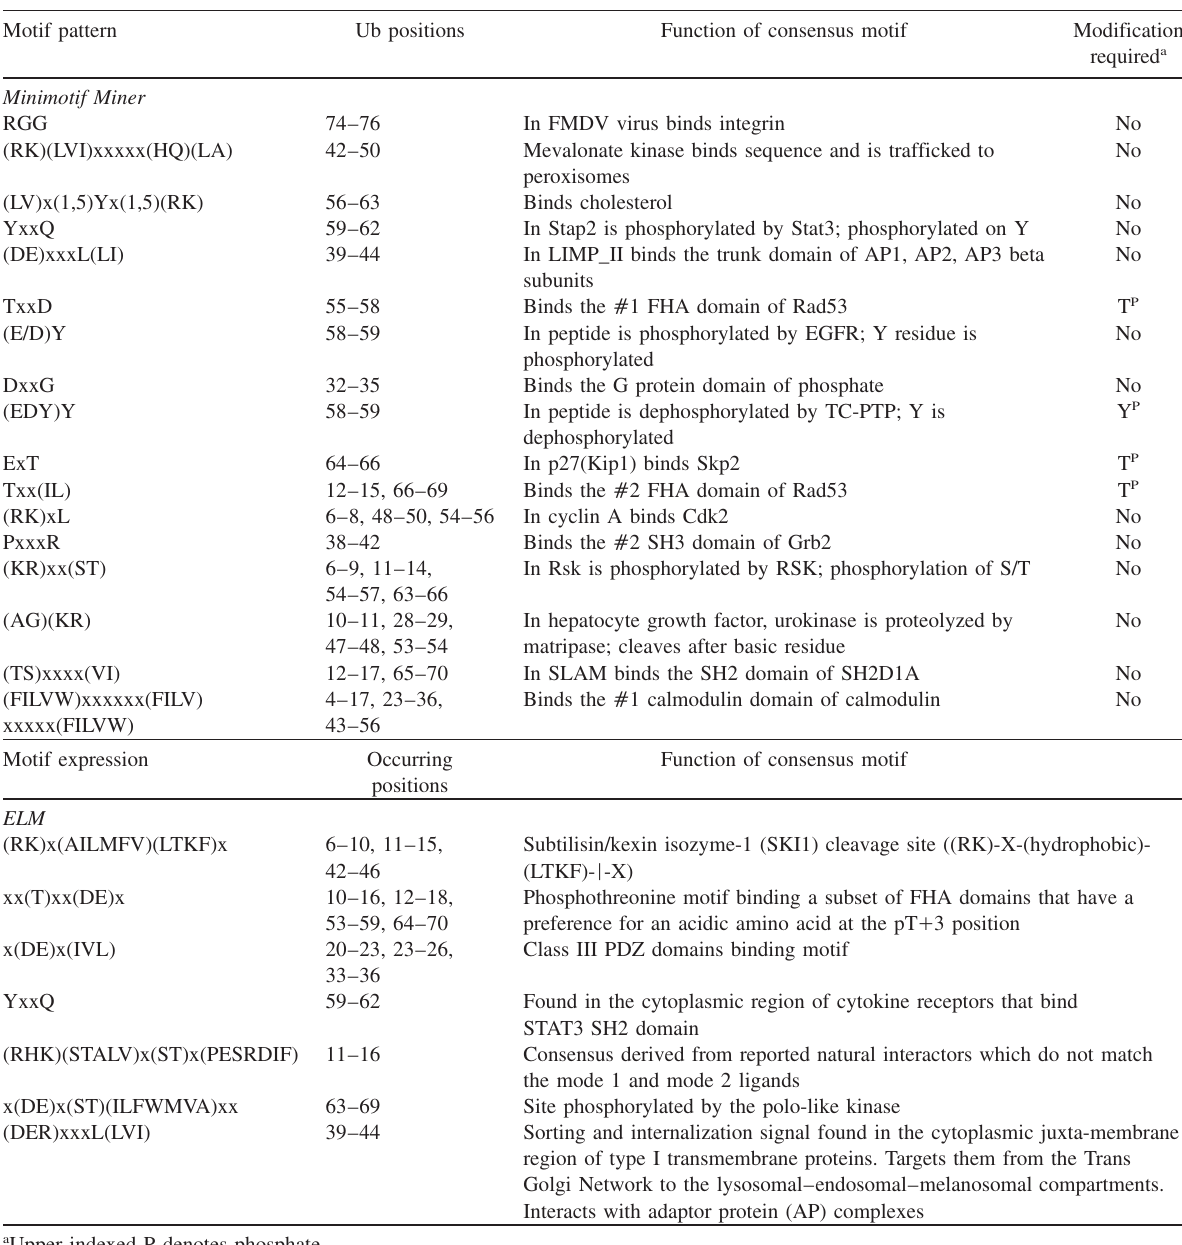
Table 3 Short functional peptide motifs identified in ubiquitin sequence by Minimotif Miner (76) and ELM